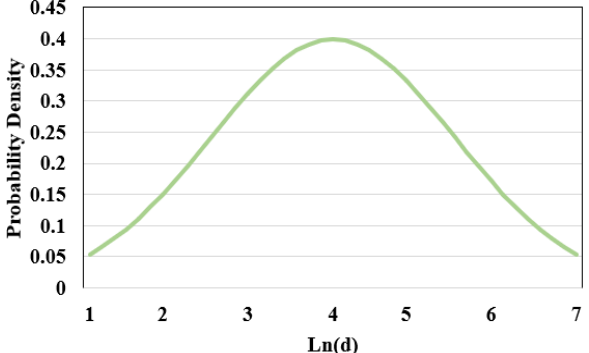
Fig.1. Probability Density Function of daily distance travelled by PHEV